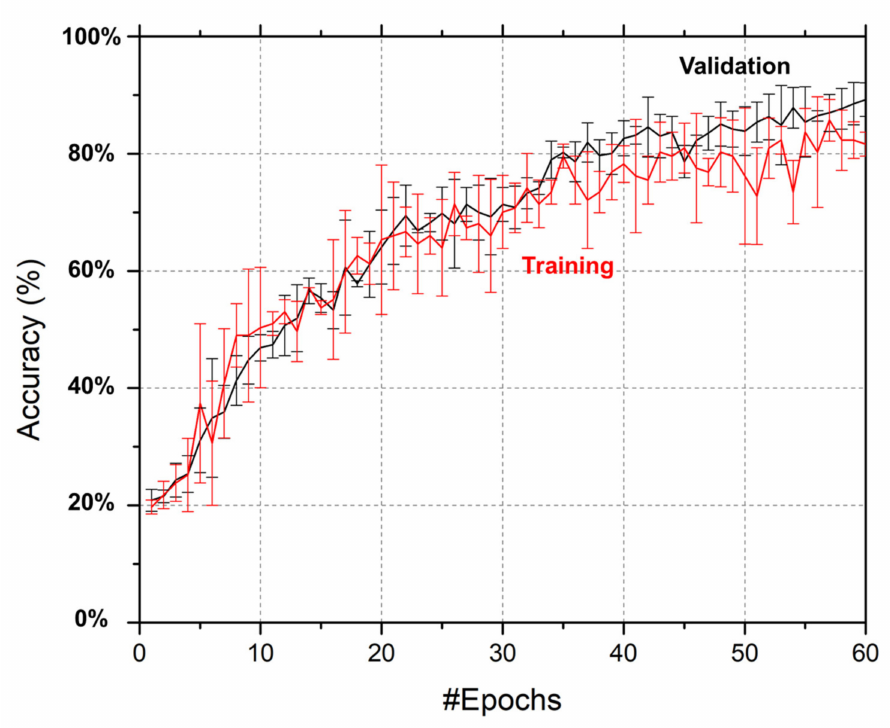
Figure 6. Accuracy curves for training and validation of our optimized deep learning model. Error bars represent the standard deviations of three replicate experiments using the same parameters, 64: 3: Color: